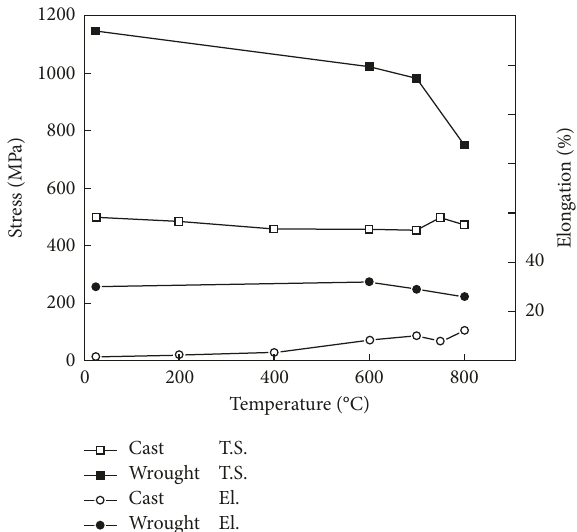
Figure 5: Tensile properties of Haynes 282 cast and wrought alloys at various test temperatures.